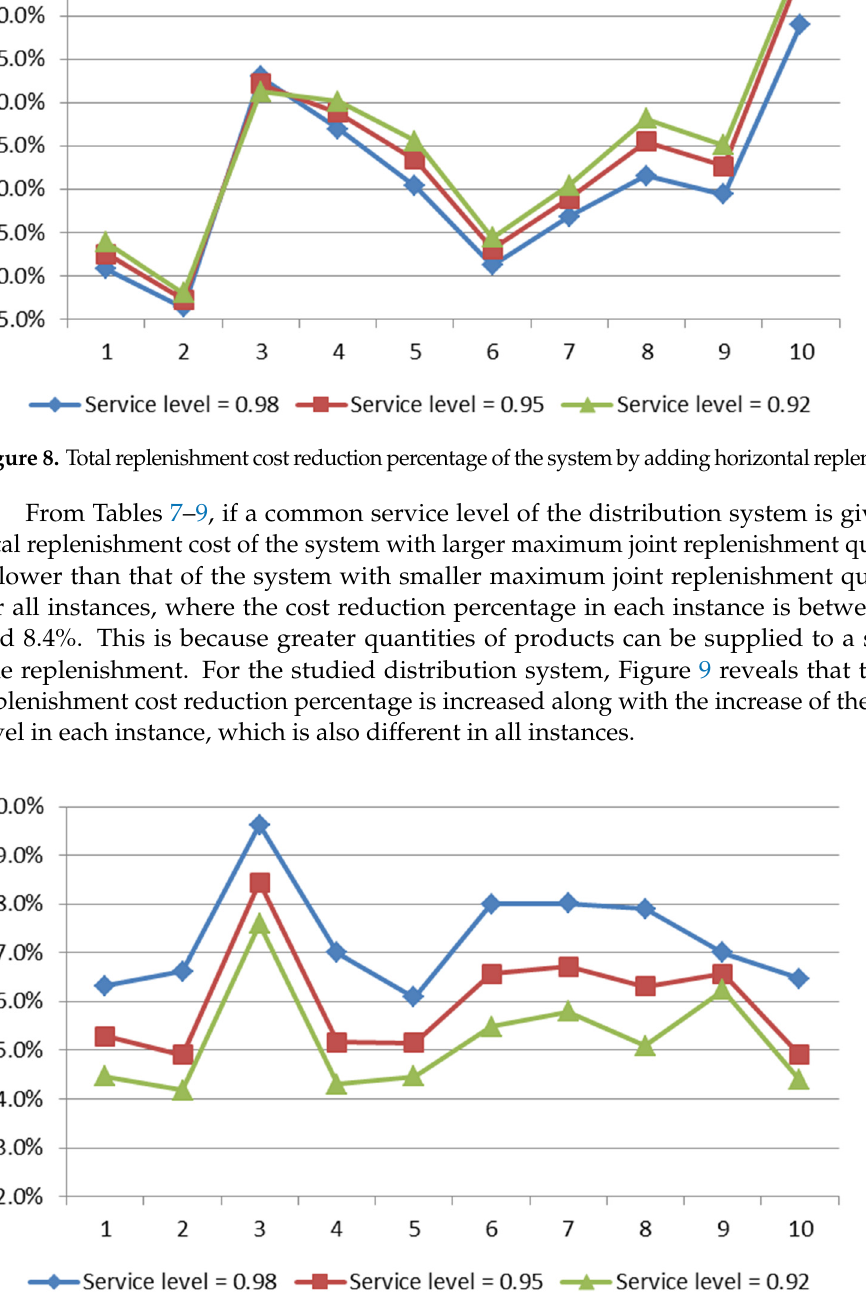
Figure 9. Total replenishment cost reduction percentage of the system by increasing the maximum joint replenishment quantities.